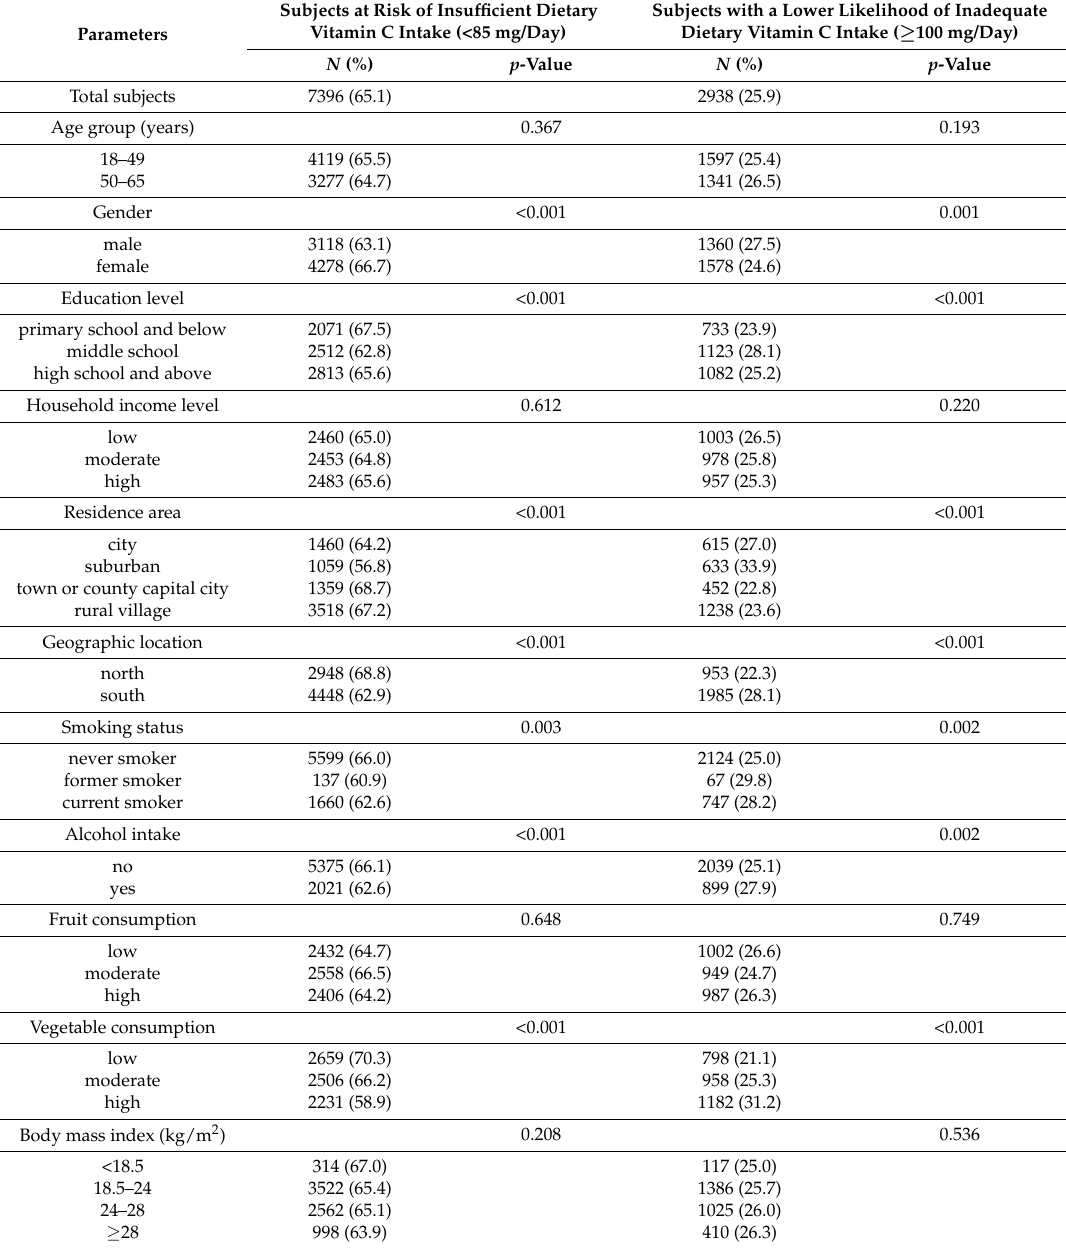
Table 2. Proportion of subjects at risk of insufficient dietary vitamin C intake and proportion of subjects with a lower risk of insufficient dietary vitamin C by sociodemographic